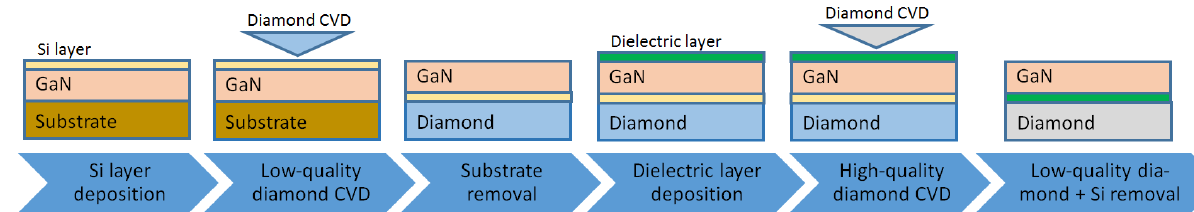
( b ) Figure 19. ( a ) Fabrication steps of a GaN-on-diamond membrane. ( b ) Image of the 5 mm-diameter membrane inside the MPCVD system and corresponding thermally-induced mechanical displace- ment (reprinted from [95]; permission conveyed through CCBY 4.0.).